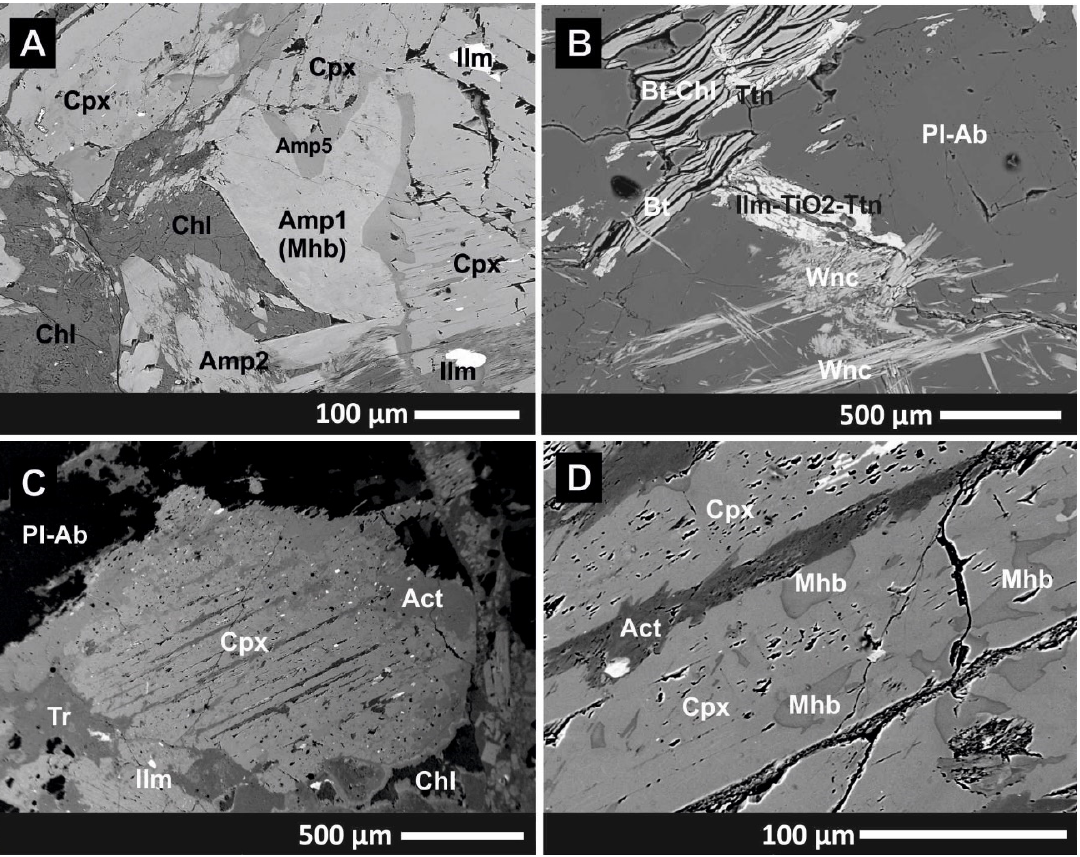
Figure 13. BSE images of gabbros and a plagiogranite from inferred gabbro layer of the OOC oceanic crust. ( A ) Cpx ‐ Pl ‐ Amp1(Mhb) ‐ Ilm gabbro (P13B1) with newly formed aggregate of Amp5, Chl, Ab, Ttn. ( B ) Plagiogranite (P5B) with deformed chloritized Bt associated with needle ‐ like Amp1(Wnc) aggregates in the secondary assemblage of Ttn, TiO 2 , and Chl. ( C ) Leucogabbro (P13B2) composed of Cpx, Pl, Amp1 (visible in D), and Ilm. ( D ) Leucogabbro (P13B2) Cpx partly replaced by Amp1(Mhb, Prg) and Amp5(Act).